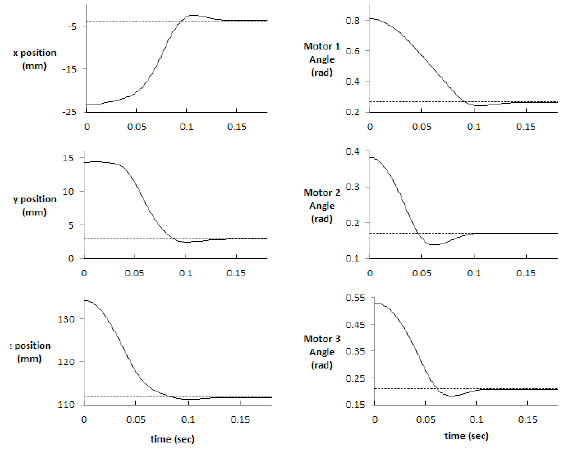
Figure 6: Step response of the designed position controller Figure 9. Step response of the designed position controller.